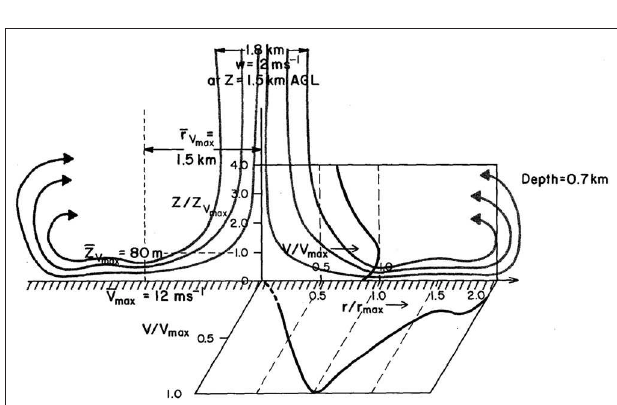
FIGURE 2 | Structure of the outflow at maximum intensity showing average values of structural features. Reproduced from Hjelmfelt (1988) with permission from American Meteorological